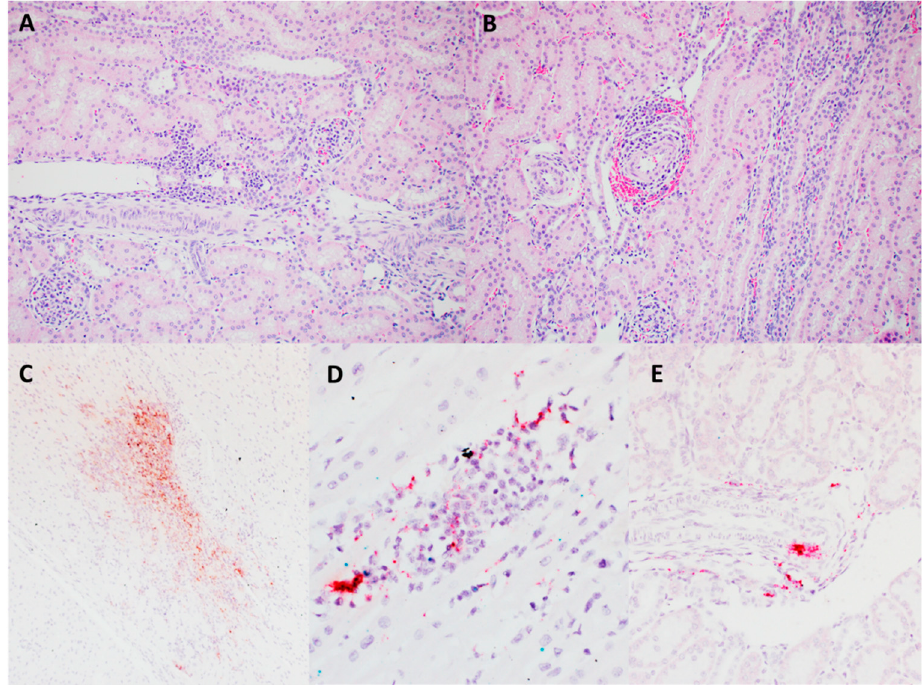
Figure 8. Microscopic lesions and RNAscope in situ hybridization on tissues collected at necropsy (28 dpi) from 6-weeks-old CD / CD PCV3 inoculated pigs. The cortical intestitu is multifocal infiltrated by small aggregates of lymphocytes and plasma cells. H&E (20 × ) ( A ). The tunica adventitia and media of multiple cortical arterioles are infiltrated by lymphocytes and plasma cells. H&E (20 × ) ( B ). PCV3 was confirmed by ISH within inflammatory foci ( C , D ) endothelial cells ( D ) within smooth muscle of arteries ( E ) H&E counterstain (20 ×